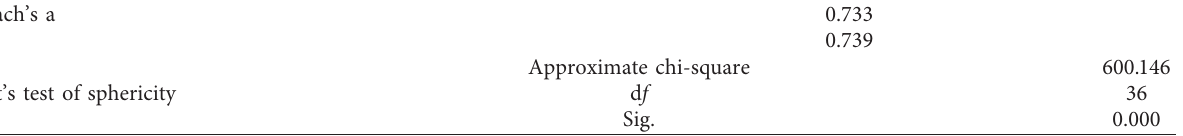
Table 6: Reliability and validity tests of the questionnaire.